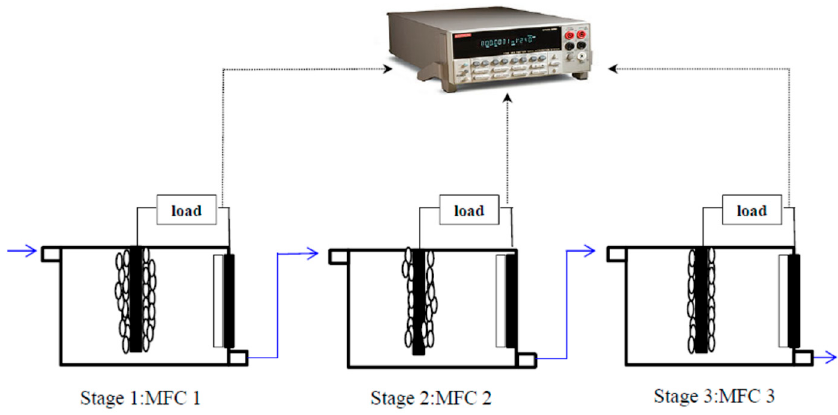
Figure 1. Schematic configuration of three-stage SCMFC system.